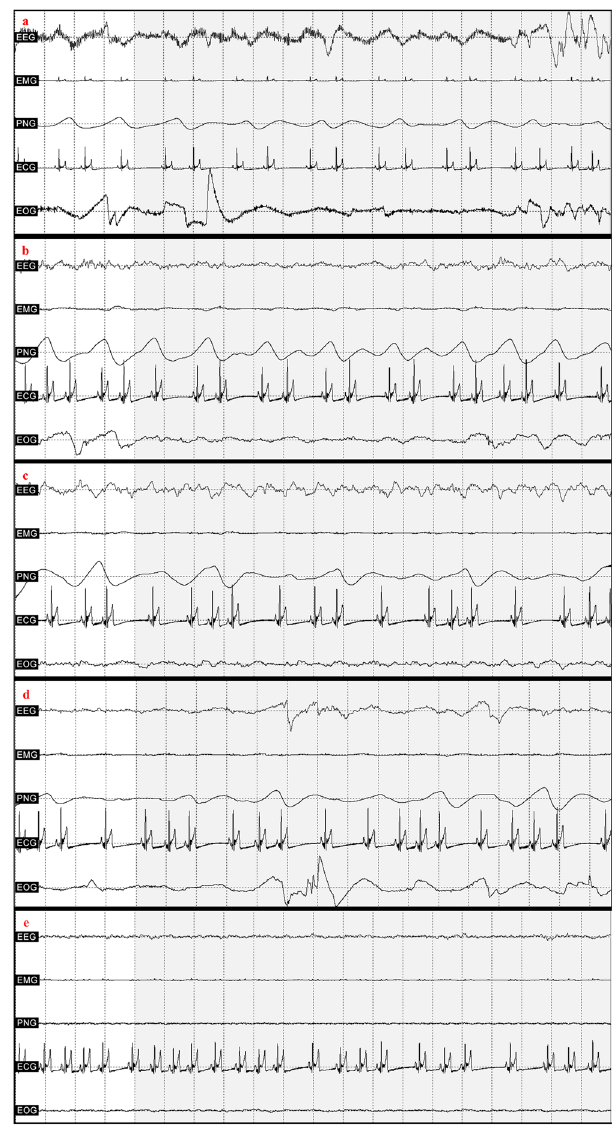
Figure 5. Representative EEG traces from the different sleep stages . Note . a = wake, b = drowsiness, c = NREM, d = REM with eye movement, e = REM without eye